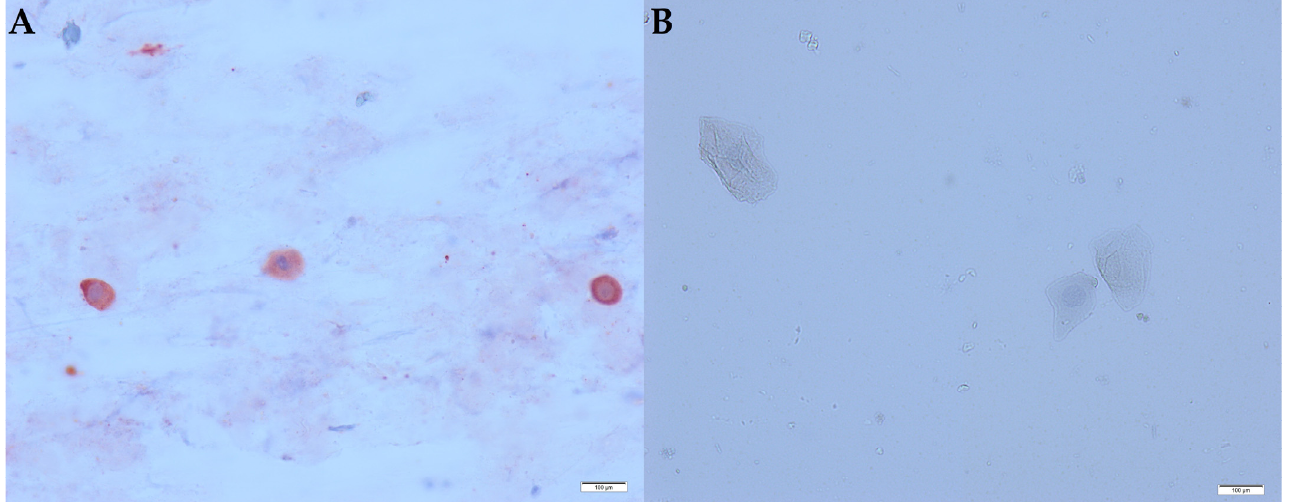
Figure 1. Immunocytochemistry of a nasal swab smear of a hippo. Magnification 40×. ( A ) Hippo with SARS-CoV-2 antigen in mononuclear cells; ( B ) hippo without SARS-CoV-2 antigen in squamous epithelial cells, bar = 100 µm.